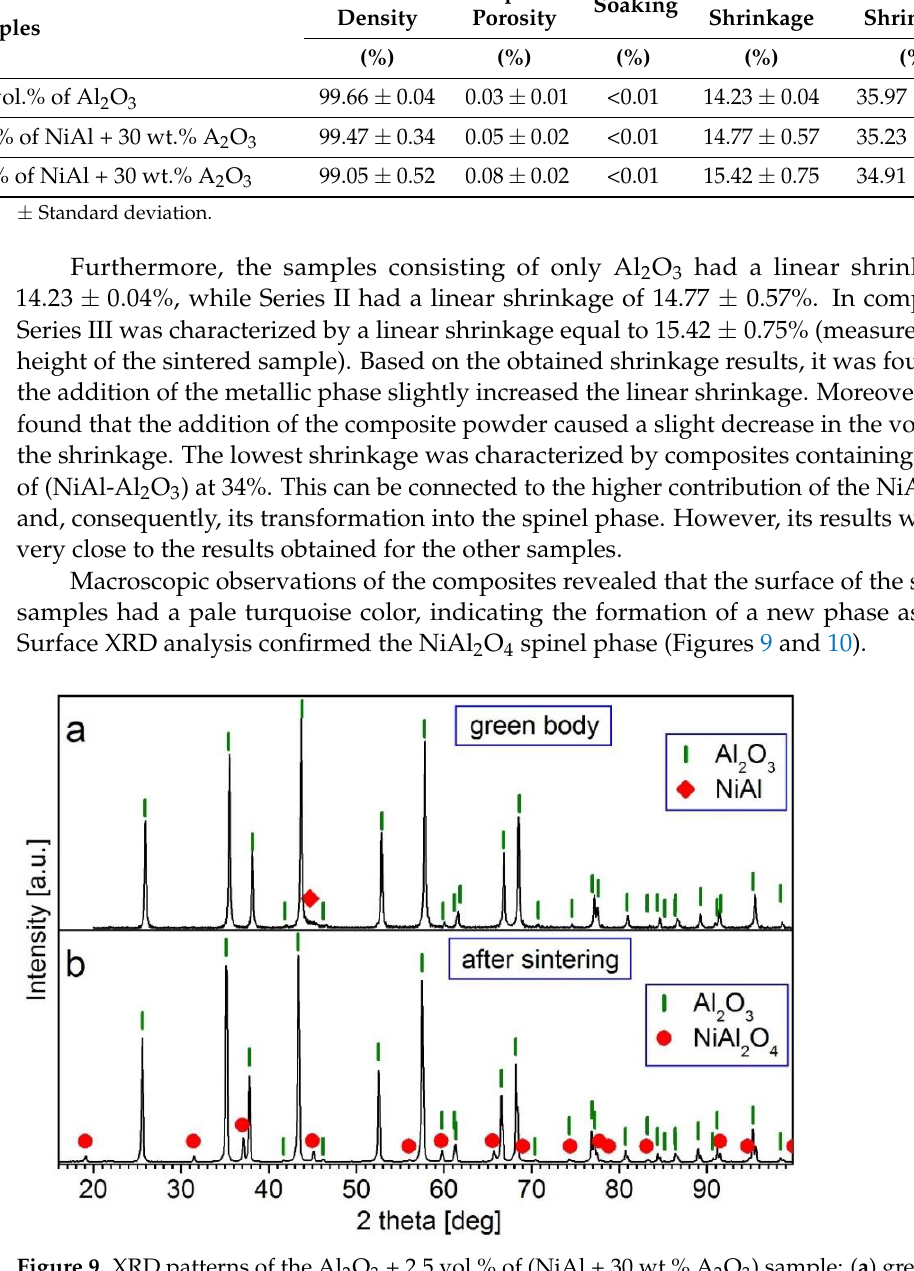
Figure 10. XRD patterns of the Al 2 O 3 + 5 vol.% of (NiAl + 30 wt.% A 2 O 3 ) sample: (a) green body; (b) after sintering at 1450 °C for 2 h. Figures 9 and 10 show the XRD patterns of the Series II and III samples before (green body) and after sintering in air at 1450 °C. In the patterns for the green bodies (Figures 9a and 10a), diffraction peaks of the Al 2 O 3 (ICDD 10-0137) and NiAl (ICDD 20-0019) phases were present. This shows that no reaction between the suspension components occurred during the mixing of the mechanically alloyed composite powder and Al 2 O 3 powder in the PM400 planetary ball mill. On the contrary, in the XRD patterns of the sintered sam- ples at the surface area (Figures 9b and 10b), there were peaks of the Al 2 O 3 (ICDD 10-0137) and NiAl 2 O 4 (ICDD 10-0339) phases, whereas there were no peaks of the NiAl phase. This shows that a reaction between NiAl and a part of Al 2 O 3 as well as the formation of a NiAl 2 O 4 spinel occurred during sintering. In the central part of the composites, there was also the formation of NiAl 2 O 4 spinel, which was expected. The SEM microstructural images of the obtained specimens are shown in Figure 11. The samples in Series I (pure Al 2 O 3 ) contained only alumina (Figure